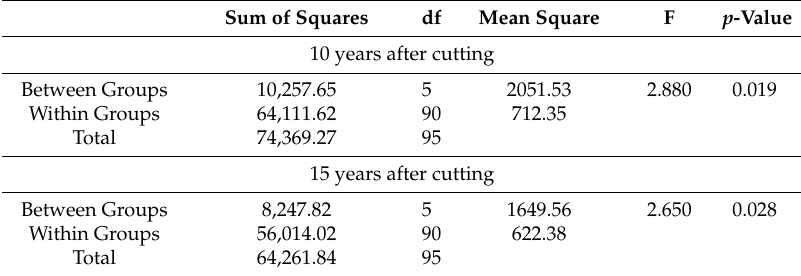
Table 8. ANOVA results on the impacts of cutting intensity on overall soil properties.